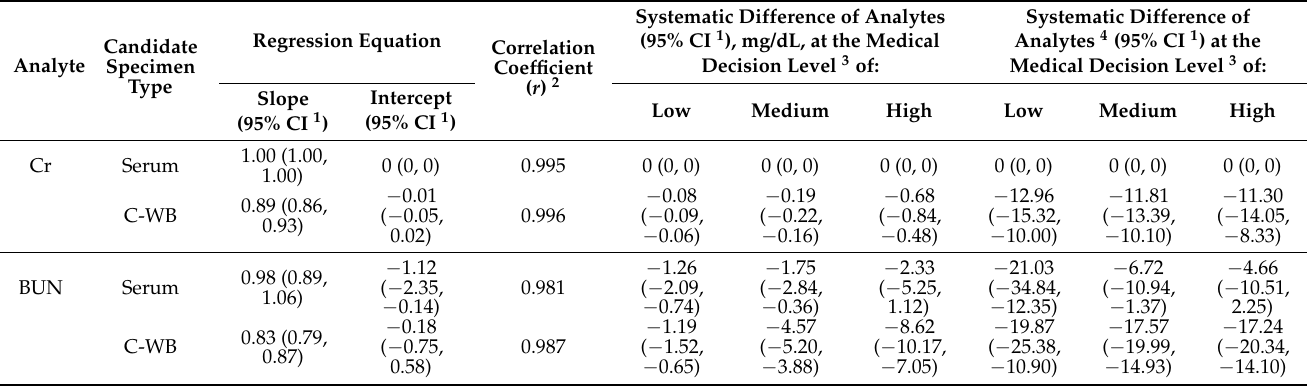
Table 2. Passing–Bablok regression and systematic differences between the primary specimen (H-WB)